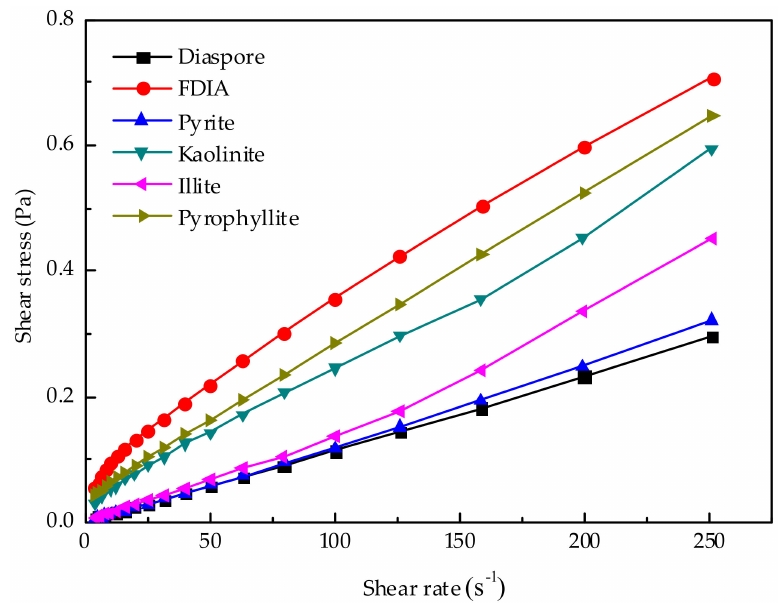
Figure 10. Rheological properties of pulp when six minerals were added to water alone.